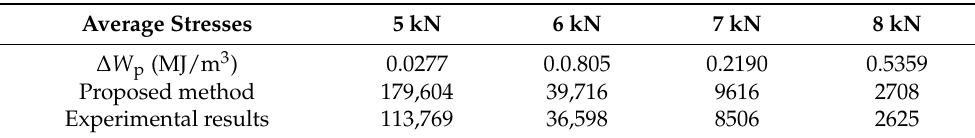
Table 11. Estimated and experimental results of the fatigue life of LY12 for different average stresses (the stress amplitude is 5